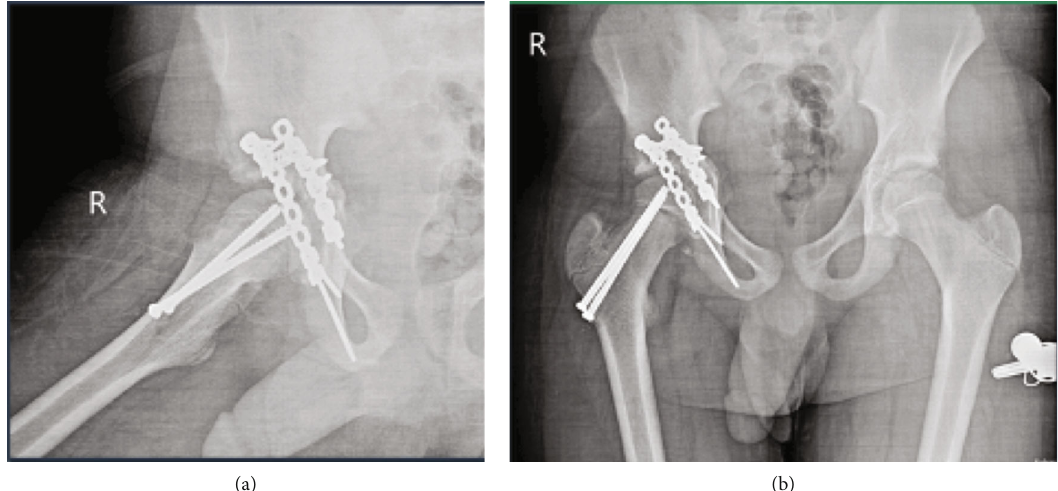
Figure 5: (a) AP and (b) lateral plain radiographs taken two months after fi xation demonstrating the maintenance of reduction and fi xation and no evidence of femoral head